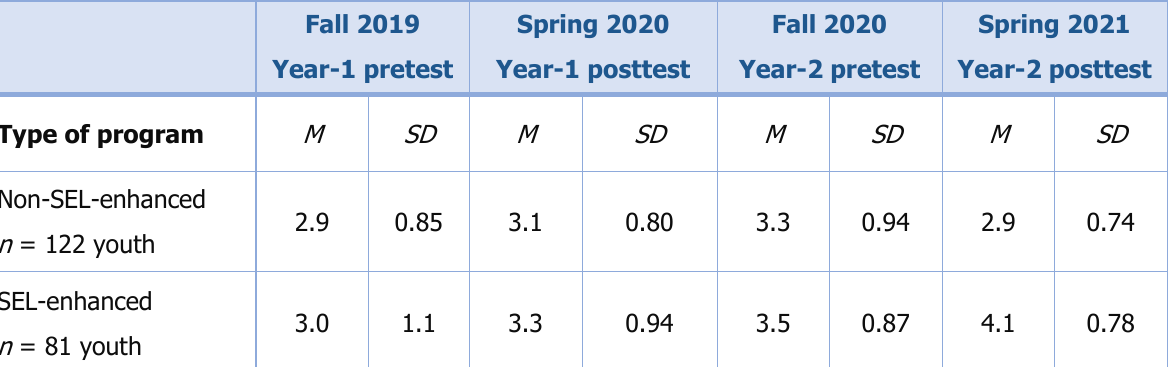
Table 5. Youth SEL Ratings at SEL-Enhanced and Non-SEL-Enhanced Programs in Years 1 and 2